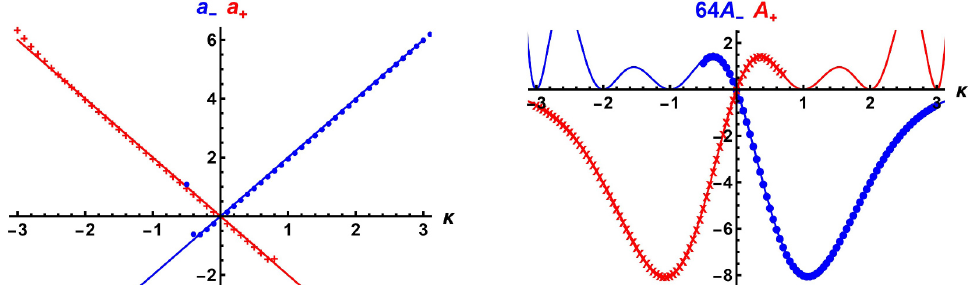
Figure 4. The second Richardson transformation of the sequences (4.9) (left) and (4.8) (right) to determine a and A as functions of κ . a are indicated by red crosses and a ± ± + , A + points with solid lines showing the analytic formula of eq. (4.5).